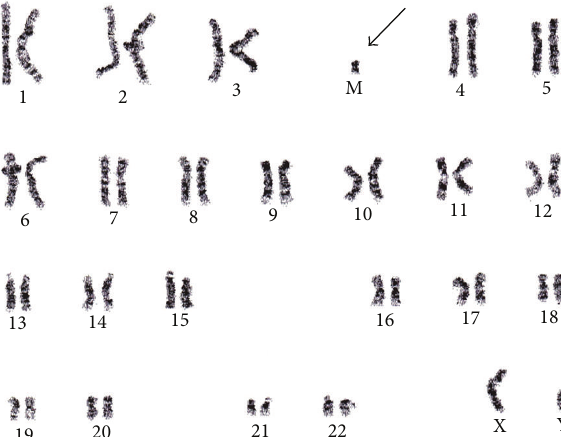
Figure 2: Patient’s karyotyping showing 47, XY, isodicentric super- numerary marker chromosome (M)